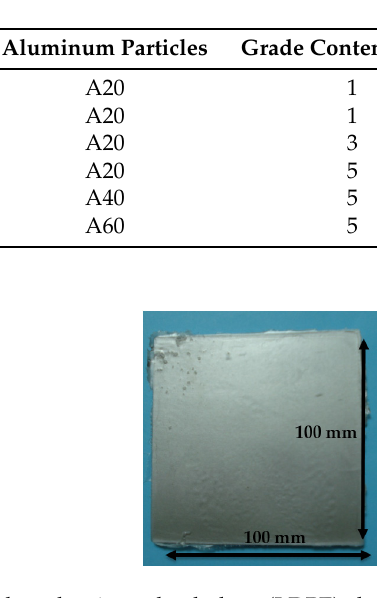
Figure 2. Experimental setup with measurement configuration. IR: infrared.